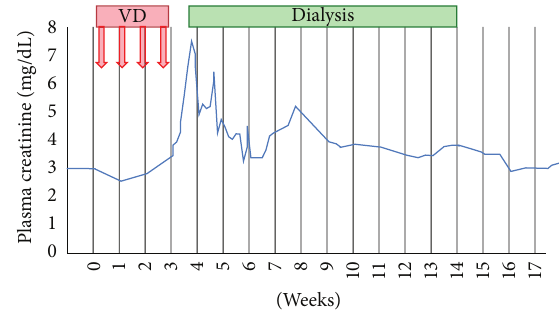
Figure 3: Evolution of proteinuria. 𝑥 -axis: time (months); 0 = start of first bortezomib administration; 𝑦 -axis: 24h proteinuria (g/24 h). VTD: bortezomib-thalidomide-dexamethasone; Rd: lenalidomide- dexamethasone; VD: bortezomib-dexamethasone.